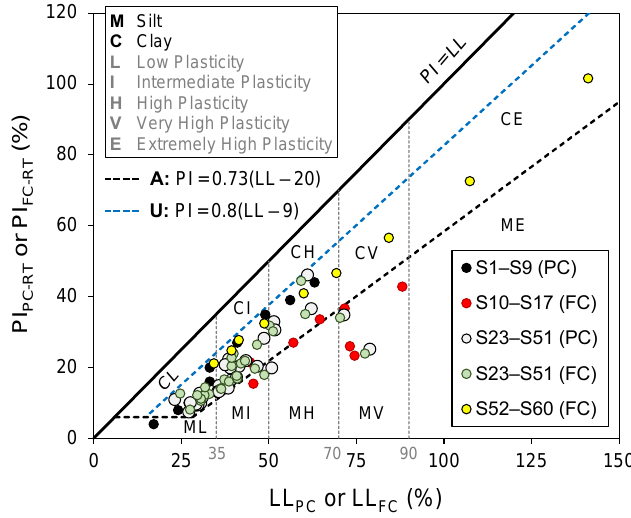
Figure 2. The database soils (excluding S18–S22 for which the LL PC or LL FC values were not reported) plotted on the standard soil plasticity chart, as per BS 5930 [9].